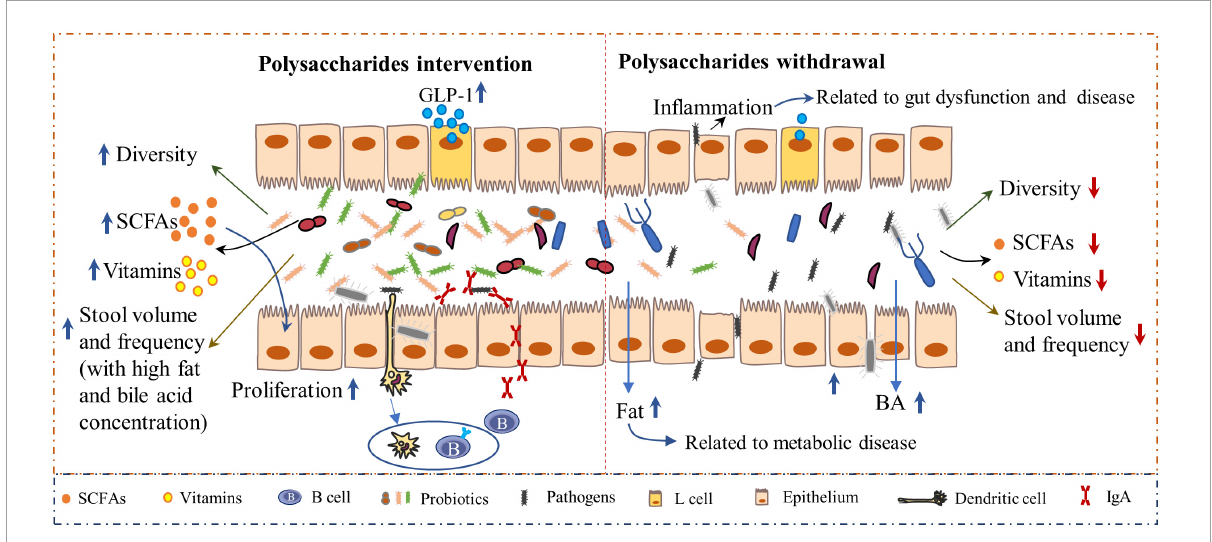
FIGURE3 The inclusion of polysaccharides has a profound impact on gut health. Polysaccharide-based interventions increased microbiota-derived metabolites, such as short-chain fatty acids (SCFA) and vitamins (Left) . SCFAs can bind to receptors on L cells and subsequently induce the secretion of glucagon-like peptide 1 (GLP-1), which can affect energy expenditure (132). Polysaccharides are highly associated with increased stool volume, frequency, and fat and bile acid concentrations (45, 46, 133), which reinforce gut health. Moreover, the intestinal immune system is enhanced by polysaccharides, as indicated by the increased secretion of immunoglobulin A (sIgA) levels. However, when the diet contains very low concentrations of polysaccharides, the balance between the gut microbiota and immunity will be disrupted (Right) , resulting in decreased diversity of microbiota with an increased abundance of pathogens, which elicit gut inflammation and subsequent bowel